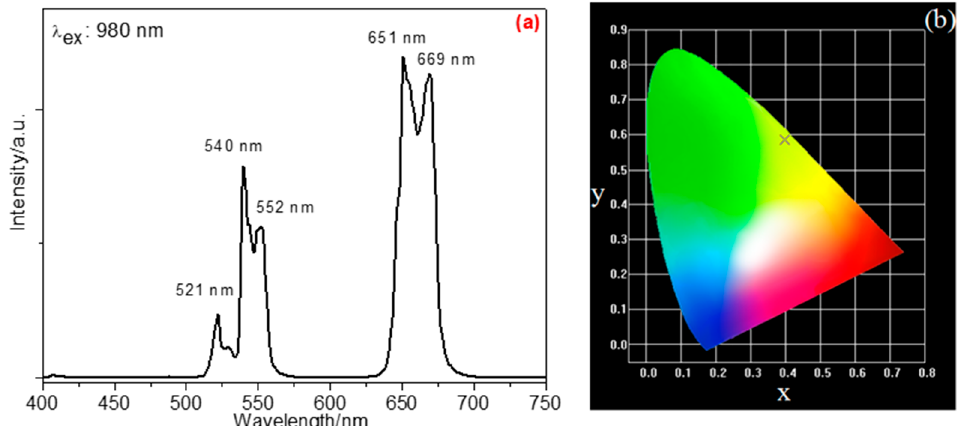
Figure 4. ( a ) Up-conversion luminescence spectrum at room temperature and ( b ) Commission Internationale de l’Eclairage (CIE) chromaticity diagram of NYF:Yb 3+ ,Er 3+ (20/2 mol%) sample ( ex : 980 nm).